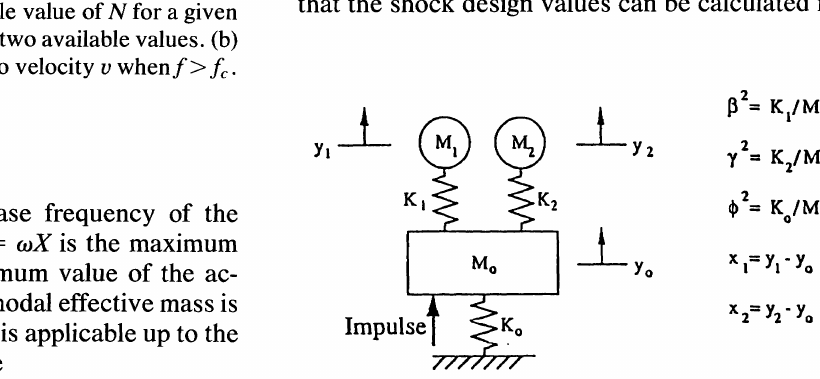
FIGURE 4 Two-degrees of freedom equipment at tached to the vehicle M o,